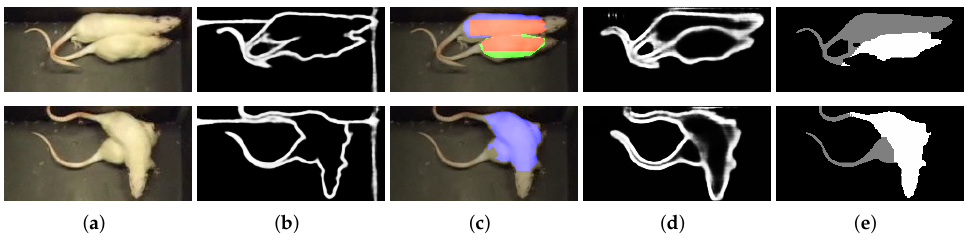
Figure 1. Images of the processing for two frames with occluding instances, with joint body seg- mentation using the Mask R-CNN [6] based method. From left to right: ( a ) input frame ( b ) original edge image ( c ) components from body part detection based on Mask R-CNN ( d ) our edge prediction giving rise to ( e ) our segmentation prediction exploiting information from body part